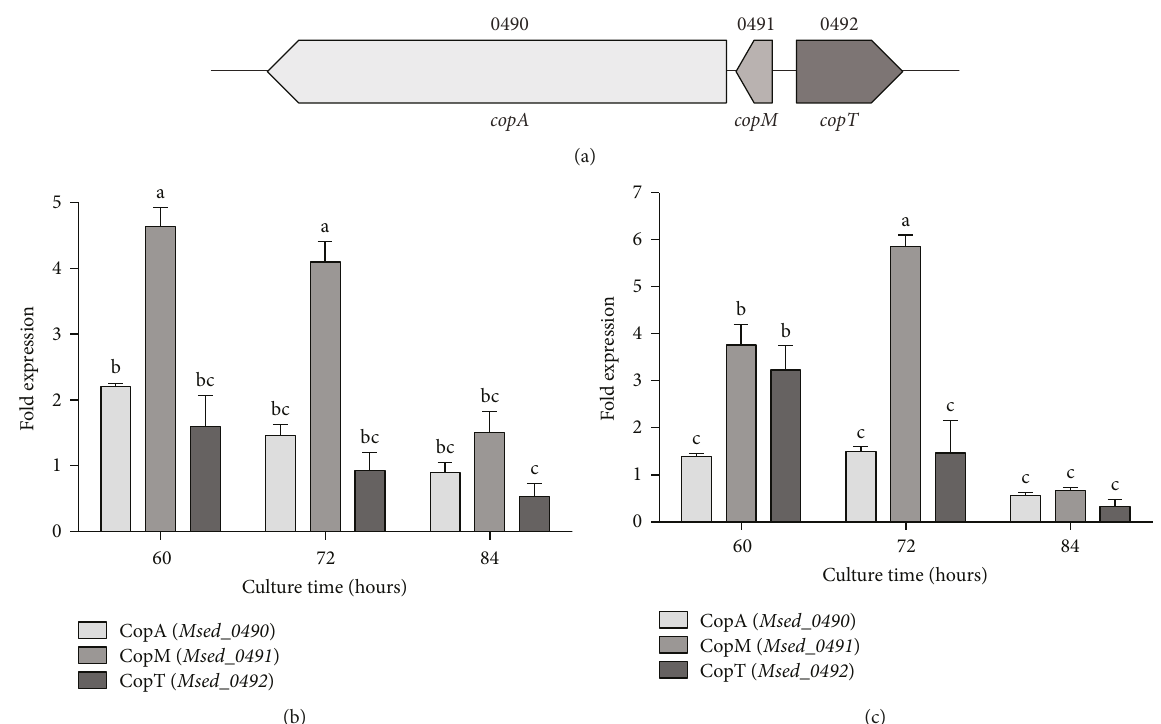
Figure 5: Transcriptional levels of copA , copM , and copT genes at di ff erent points in the growth phase of M. sedula DSM 5348 T cells grown in the presence of copper ions. (a) Diagram of the copTMA in M. sedula DSM 5348 T . Relative gene expression was quanti fi ed by qRT-PCR. (b) Nonadapted cells exposed to 8 mM CuSO . (c) Adapted cells exposed to 16 mM CuSO . Error bars indicate standard deviations based 4 4 on three di ff erent experimental values. Values with di ff erent letters di ff er signi fi cantly ( P < 0 05